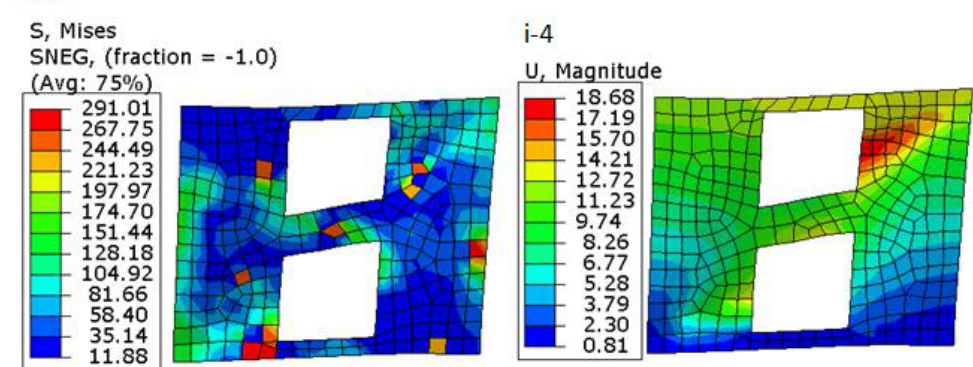
Figure 27. Von Mises stress and displacement for concrete part (i-3) stress and (i-4) displacement.